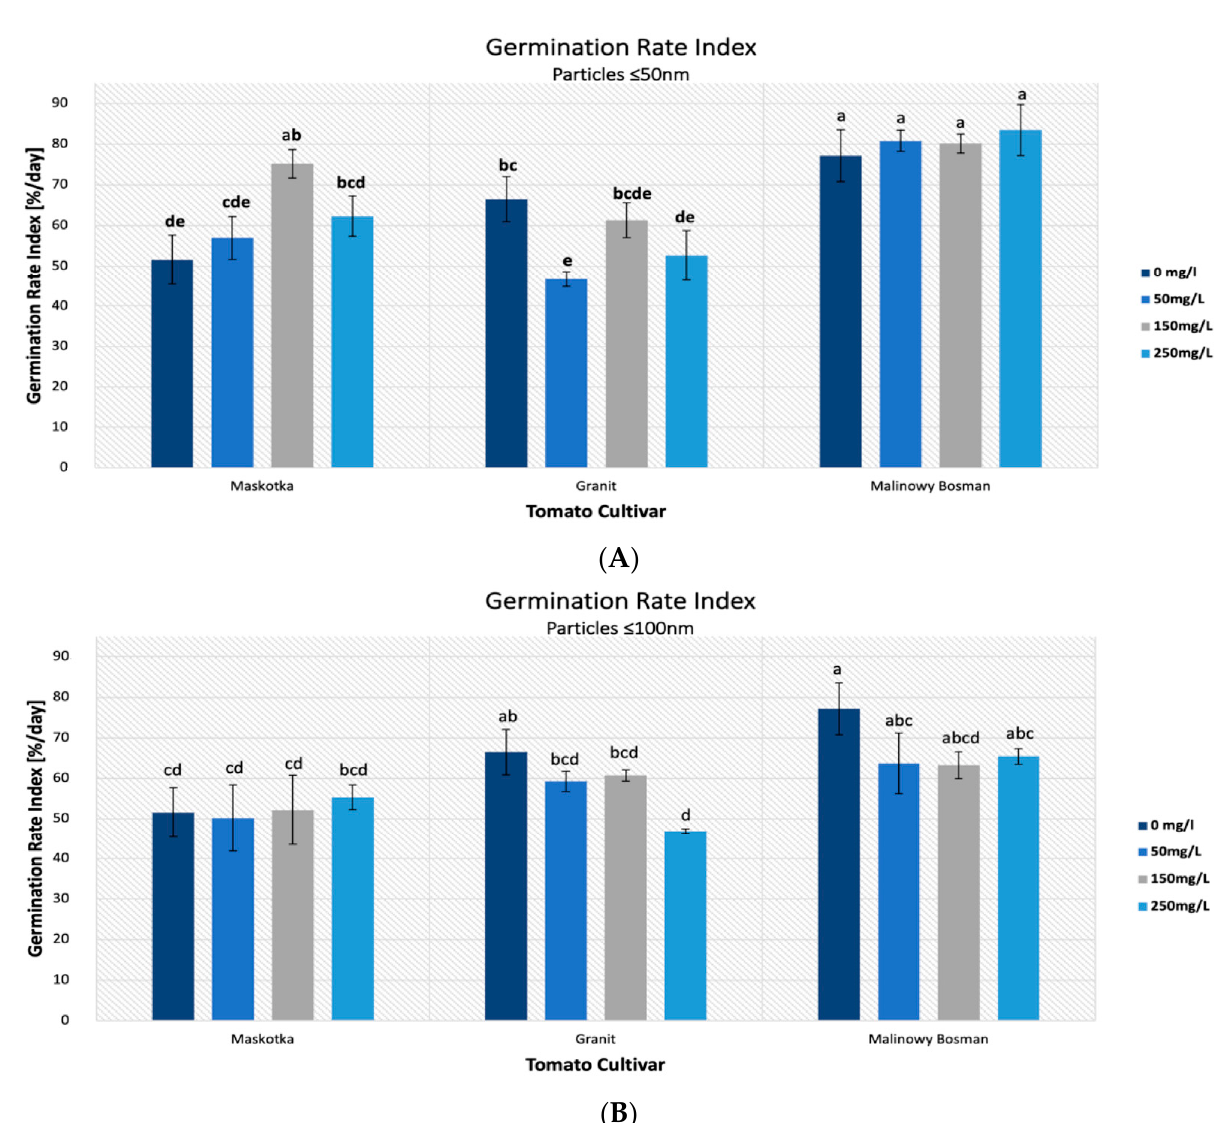
Figure 5. Effect of zinc oxide NPs (<50 nm) ( A ) and (<100 nm) ( B ) on the germination rate index (GRI) of tomato seeds after 5 days of incubation. All data are the mean of 3 replicates and vertical bars demonstrate standard deviation (±SD). Different letters indicate the significant differences for p -value ≤ 0.05 (Table A3).